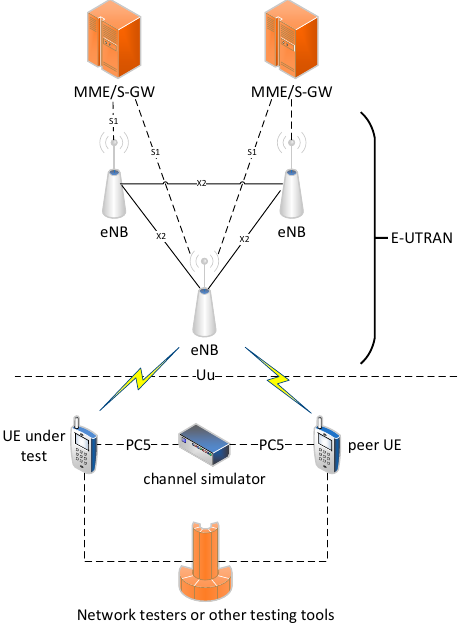
Figure 6. Terminal Performance Test System Architecture.